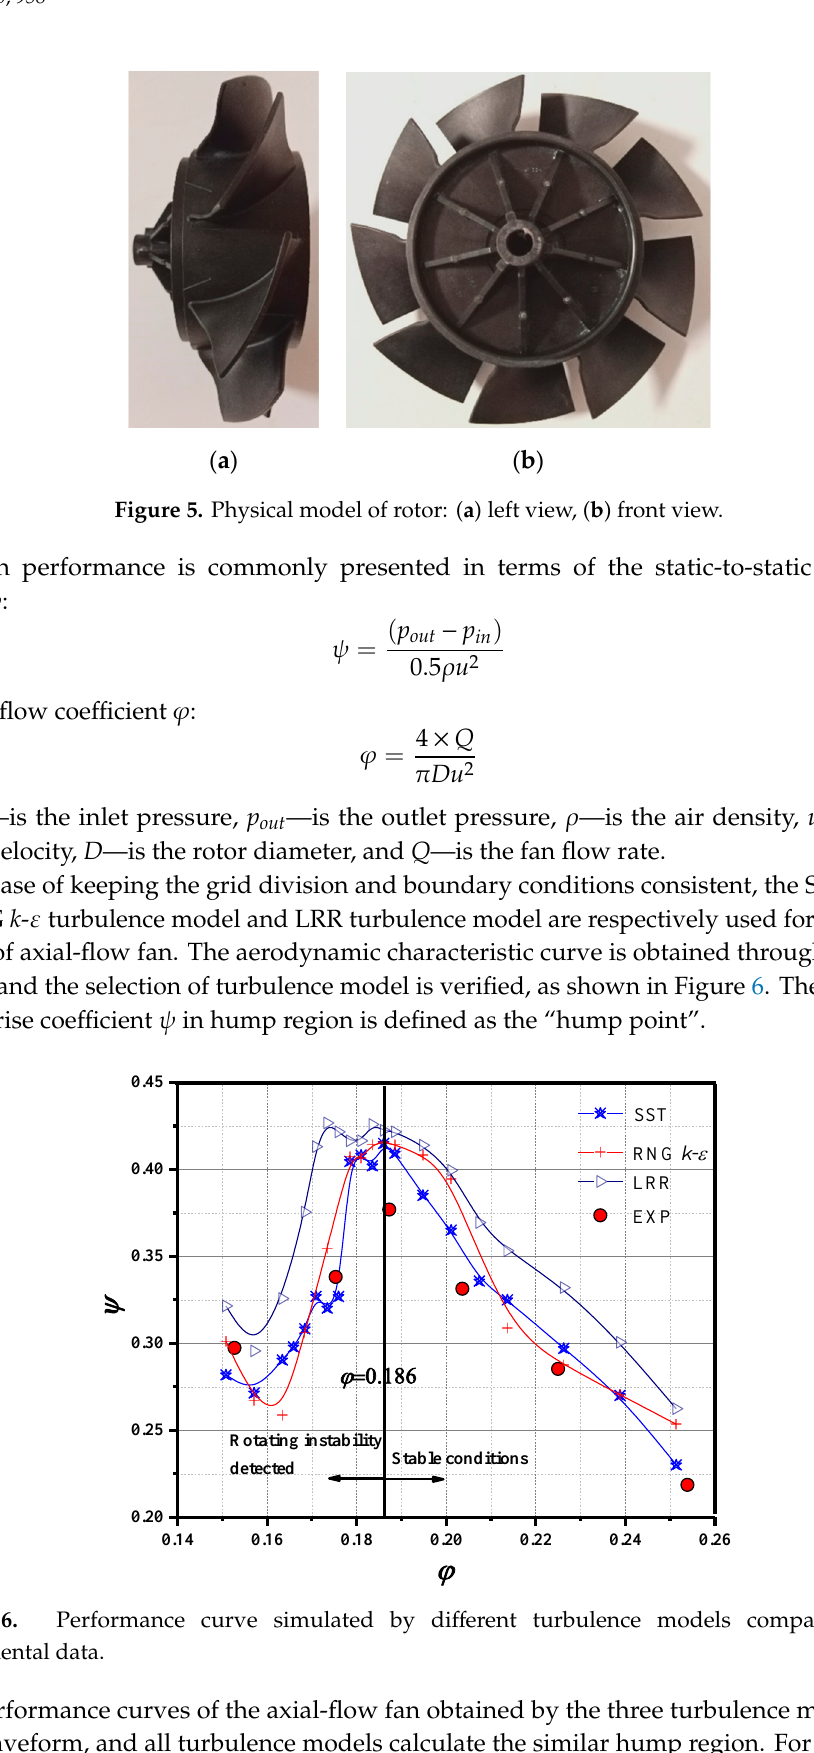
Figure 4. Experiment system for the axial-flow fan.